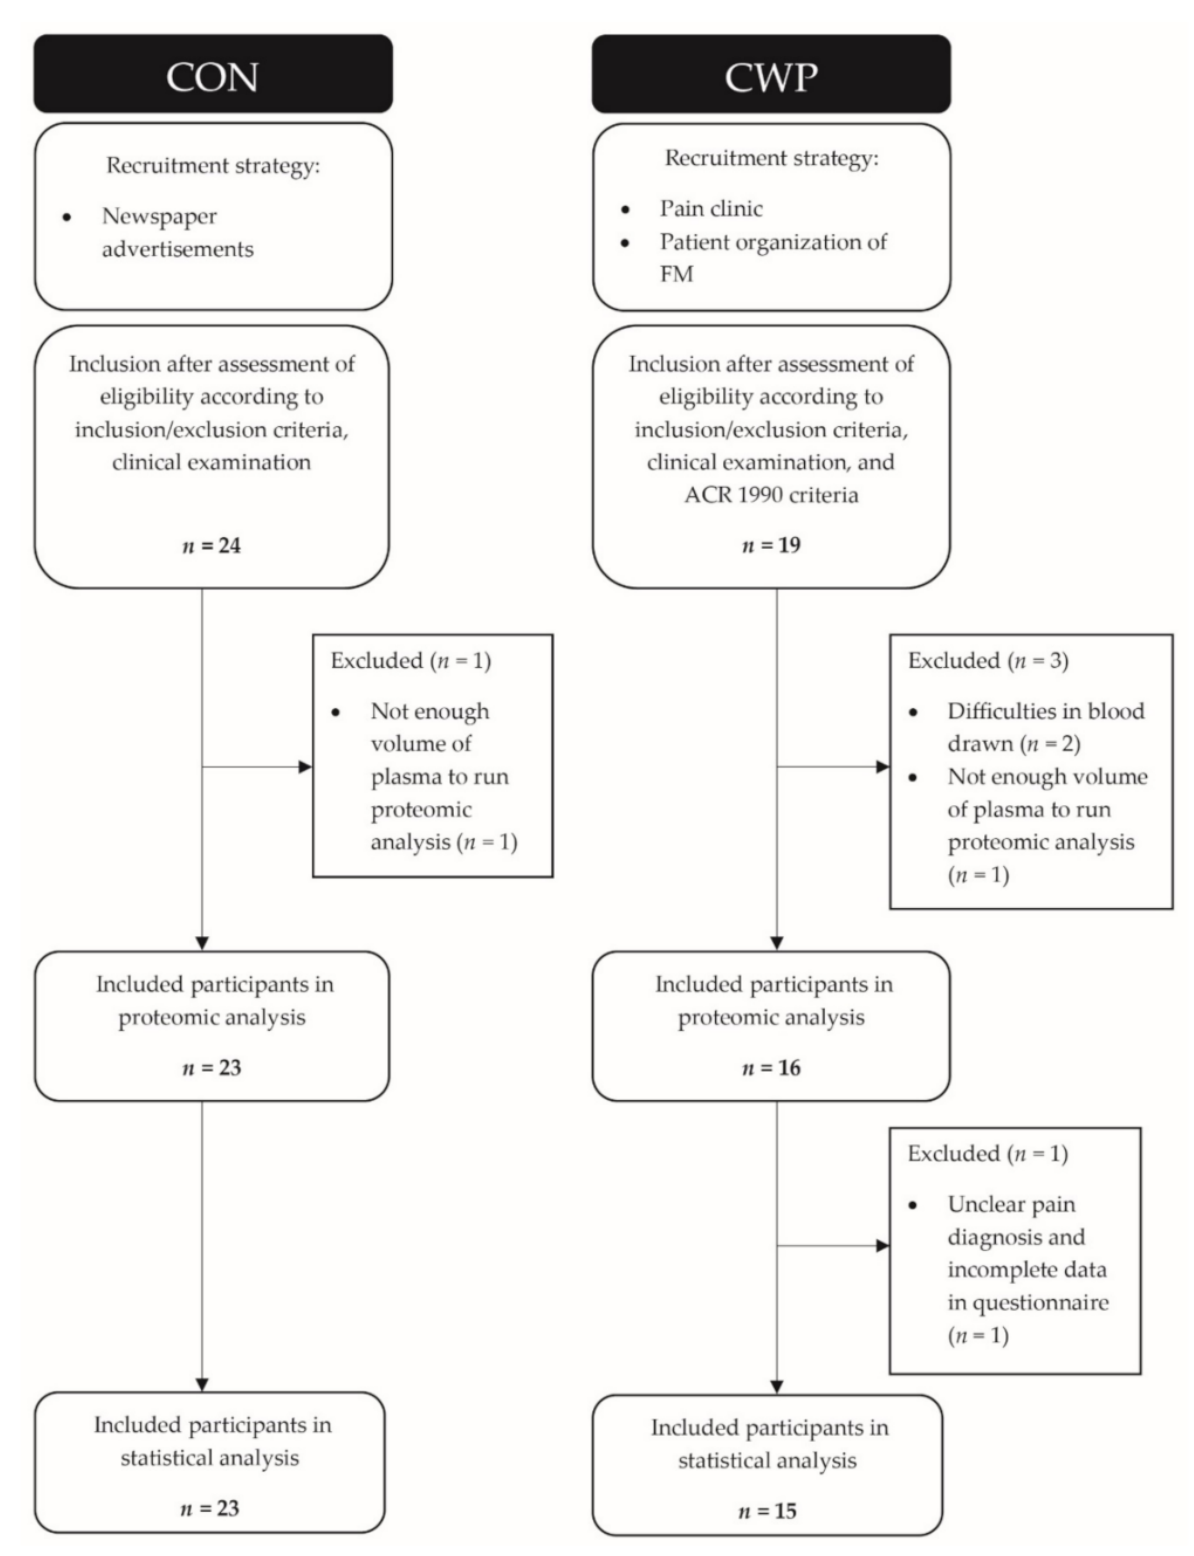
Figure 1. Flow chart of included chronic widespread pain (CWP) patients and healthy controls